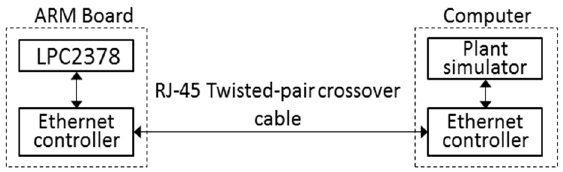
Figure 4. Hardware components of the HIL testing facility.